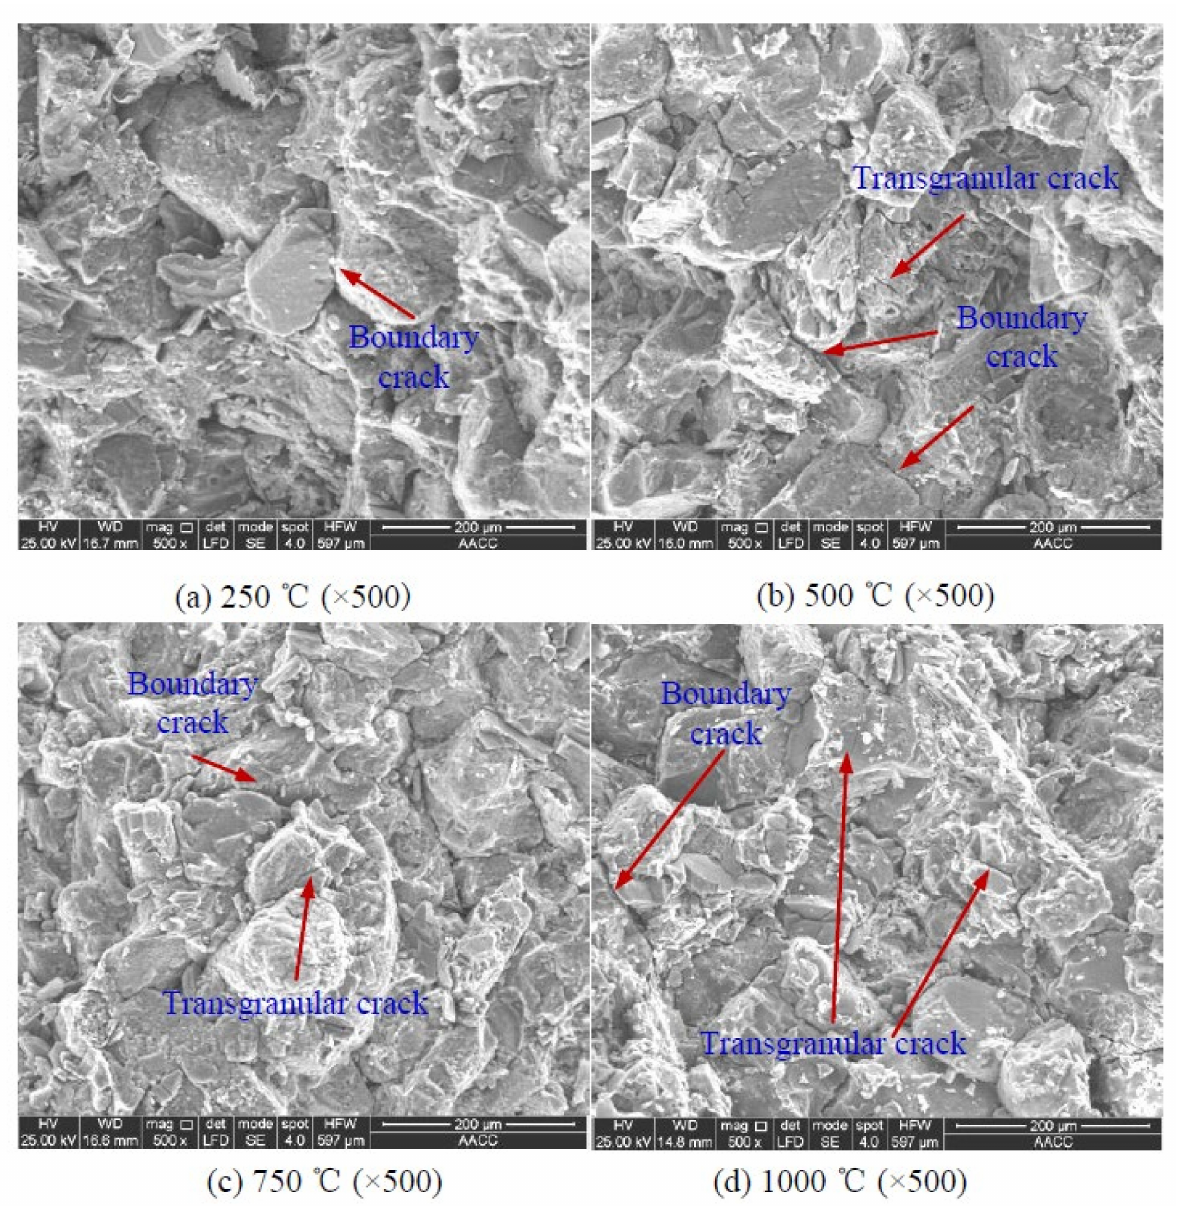
Figure 2. Sampling location, granite specimens, SEM photograph and Optical microscopy. ( a ) T = 250 ◦ C, ( b ) T = 500 ◦ C, ( c ) T = 750 ◦ C, ( d ) T = 1000 ◦